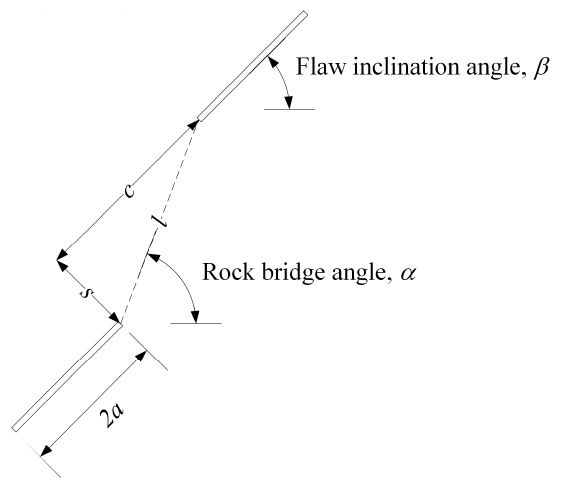
Figure 2. Specimen geometry. Table 2. List of all the geometries and the number of